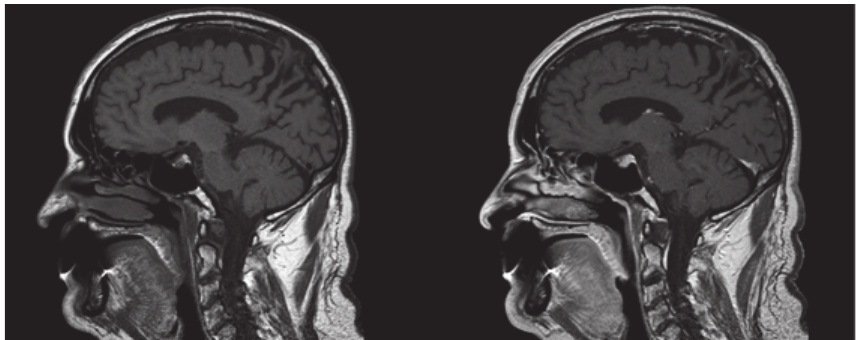
Figure 2: Sagittal T1-weighted images without and with contrast show brain herniation to the bone defect, without enhancement.